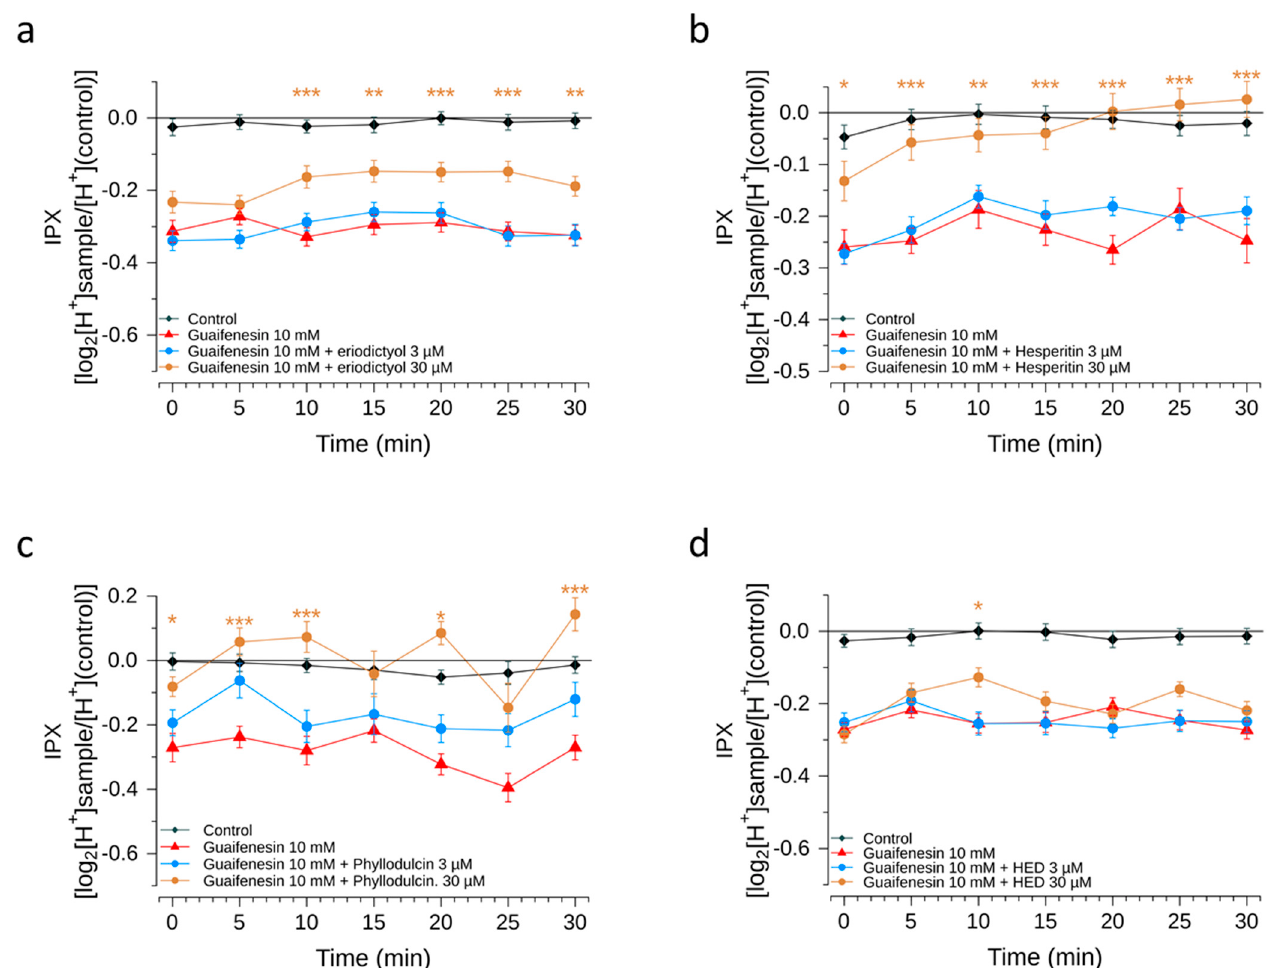
Figure 8. Guaifenesin modulation by bitter-masking compounds. Intracellular proton index (IPX) of HGT-1 cells exposed to 10 mM guaifenesin alone (red triangles) or in combination with of eriodictyol ( a ), hesperitin ( b ), phyllodulcin ( c ) and homoeriodictyol ( d ) at concentrations of 3 µM (blue circles) and 30 µM (brown circles). Recordings were performed at room temperature at intervals of 5 min. Cells treated with vehicle solution served as negative control (black diamonds). Data presented as mean ± SEM. Statistical significance was evaluated using one-way ANOVA with Tukey’s range test for multiple comparisons. * denotes p < 0.05, ** denotes p < 0.01 and *** denotes p < 0.001 for the corresponding compound according to the assigned color when compared to the negative control. N of 4 BR, 8–16 TR.